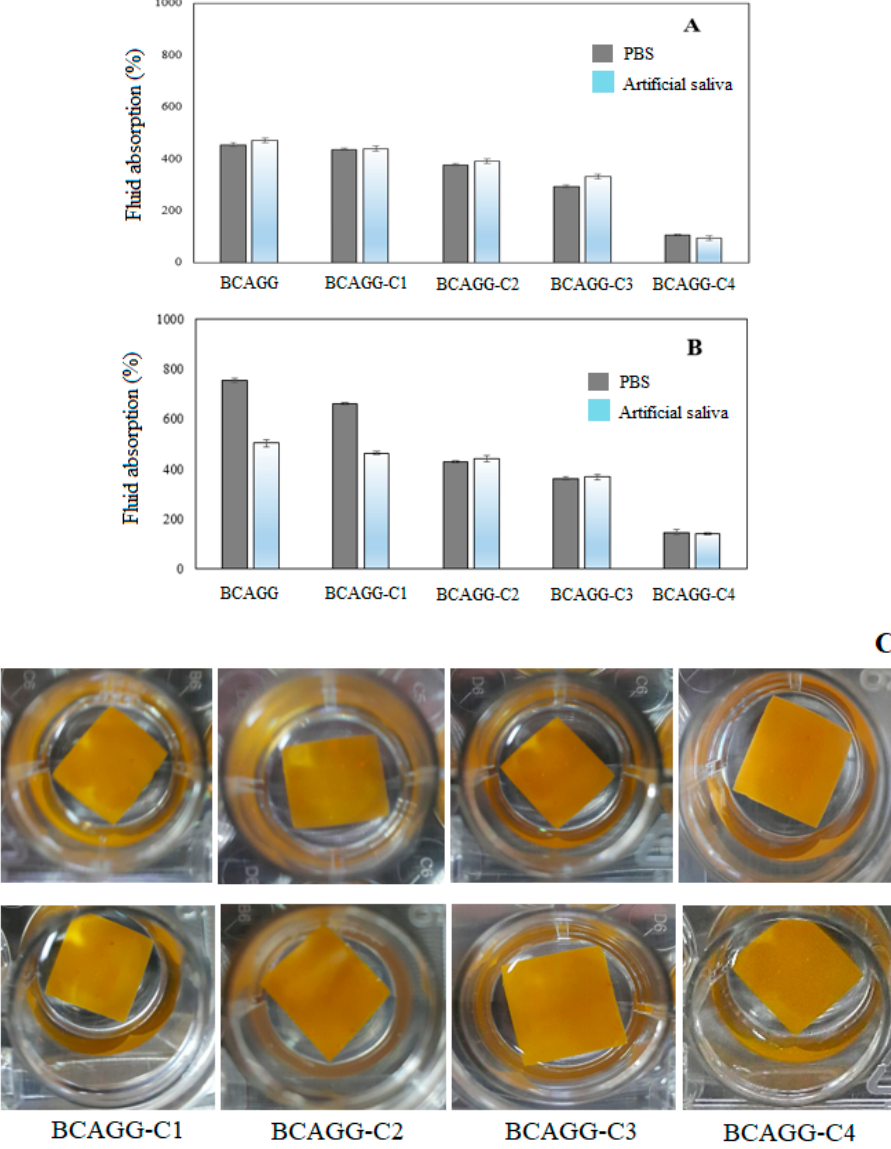
Figure 3. Fluid absorption after the immersion at 37 °C in PBS (pH 7.4) and artificial saliva (pH 6.2) for ( A ) 6 h and ( B ) 24 h; and ( C ) film samples after the immersion for 48 h.